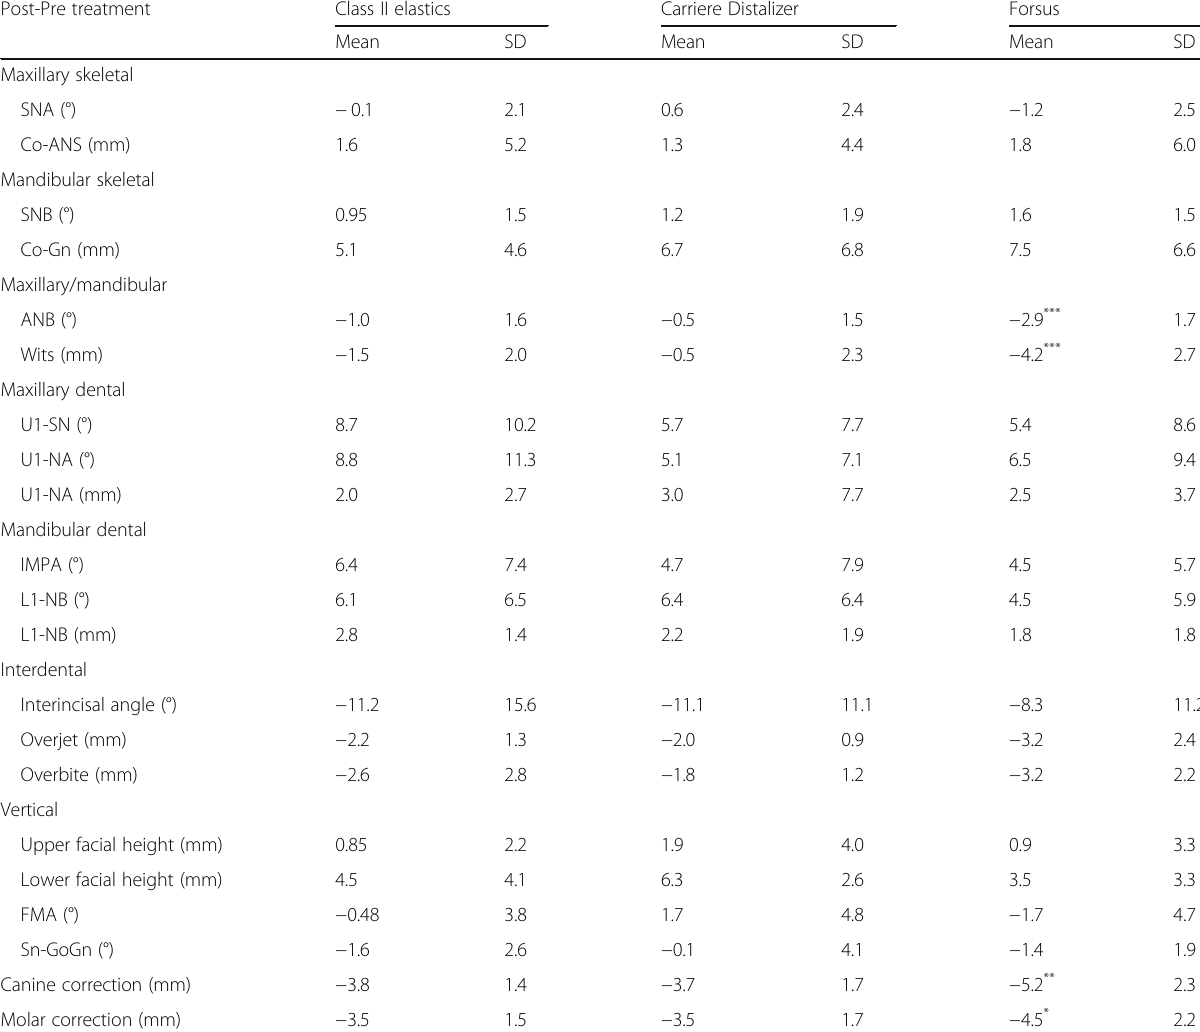
Table 4 Pre- and post-treatment changes in cephalometric measurements and canine/molar relationship correction Post-Pre treatment